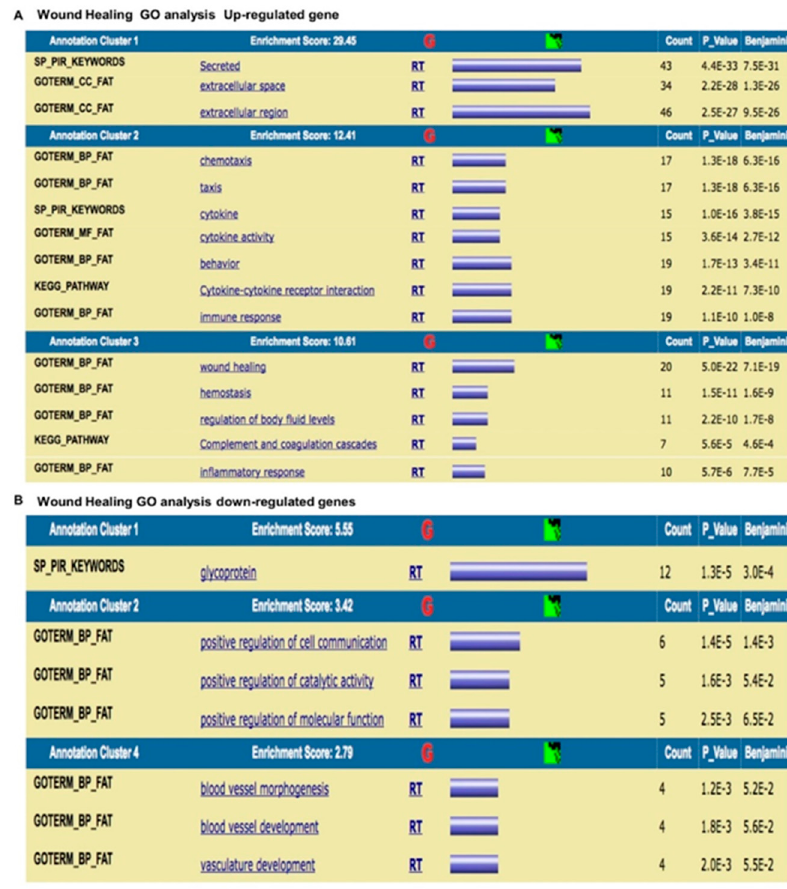
Figure 10. Gene Ontology analysis of genes related to the wound healing process. ( A ) Up-regulated genes are related to the wound healing process. ( B ) Down-regulated genes are involved in cell signaling/migration and blood vessel morphogenesis.